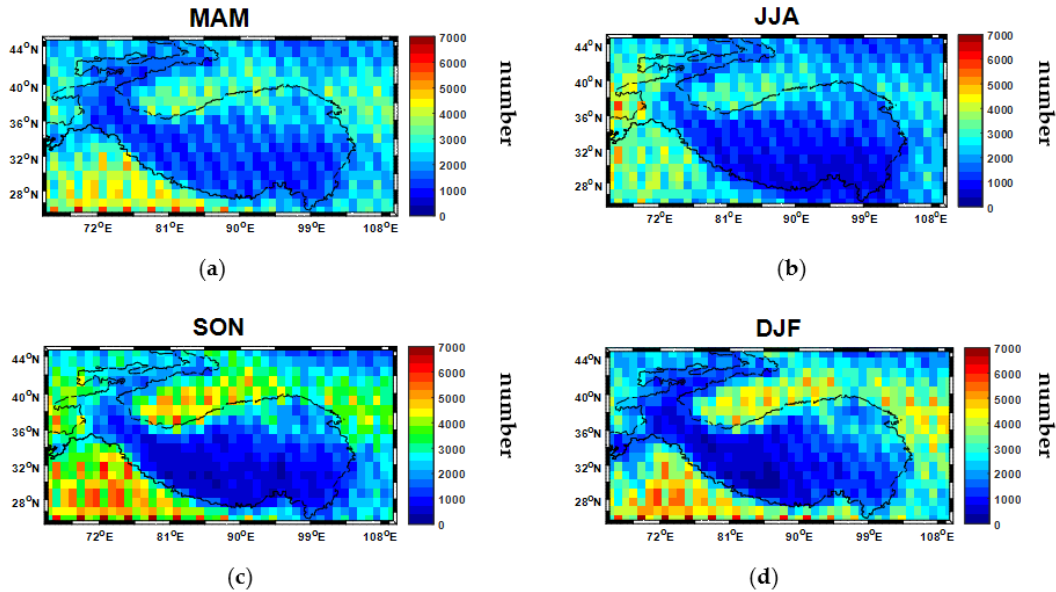
Figure 2. Seasonal maps of the samples over TP in this study: ( a ) spring, ( b ) summer, ( c ) fall, and ( d ) winter over the eight-year data period from 2007 to 2014 (The map is gridded at 1°). Each pixel represented the number of valid samples in the study.